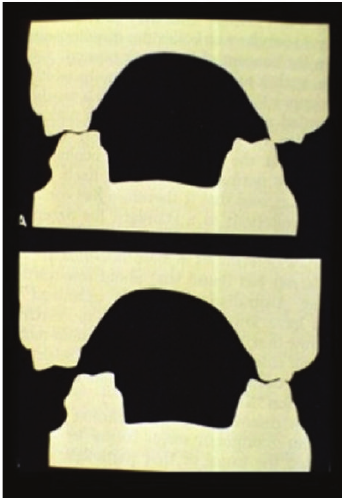
Figure 3: An example of “X-occlusion” or “alternate intercuspa- tion.” The plaster models sectioned coronally across the molars highlight the two types of centric occlusions.